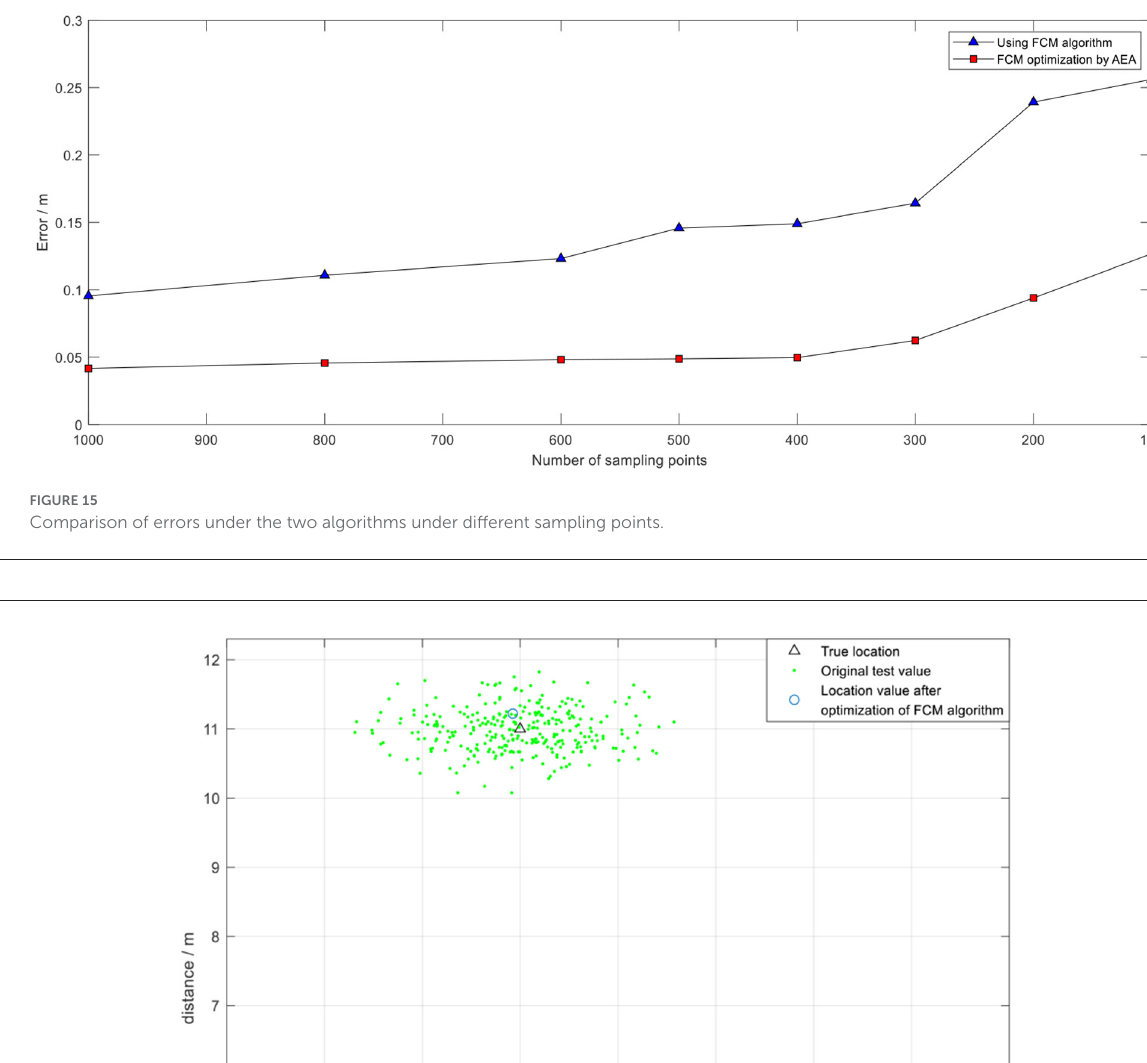
step if clustering algorithm is used to optimize wireless indoor positioning. The appropriate sampling points should be